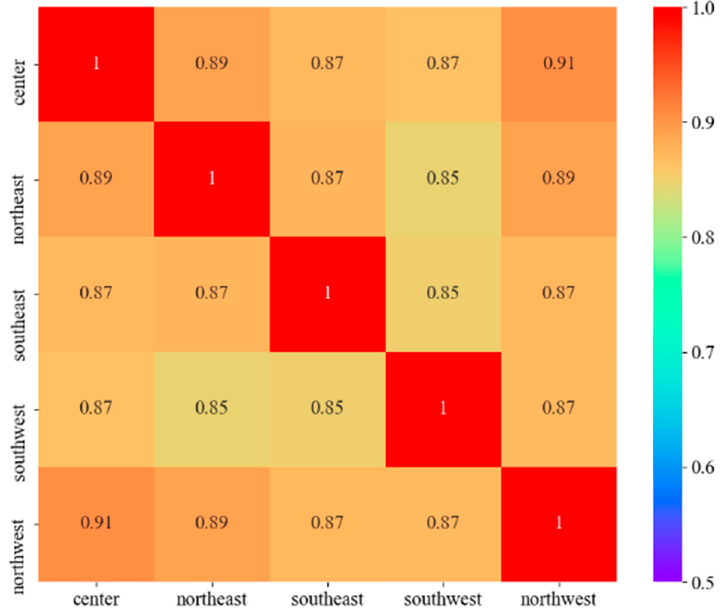
Figure 5. Heatmap of the correlation coefficient between the central station and the surrounding stations.